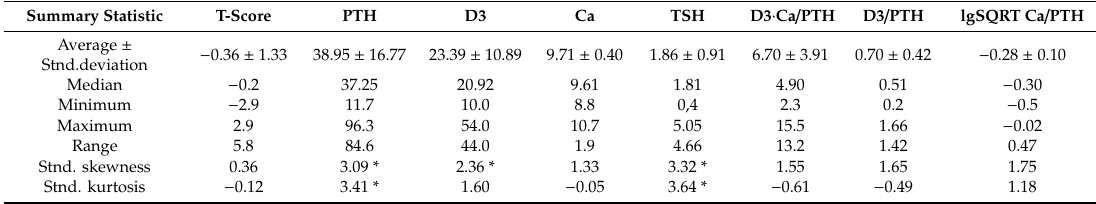
Table 2. Investigated parameters of the general mineral condition.